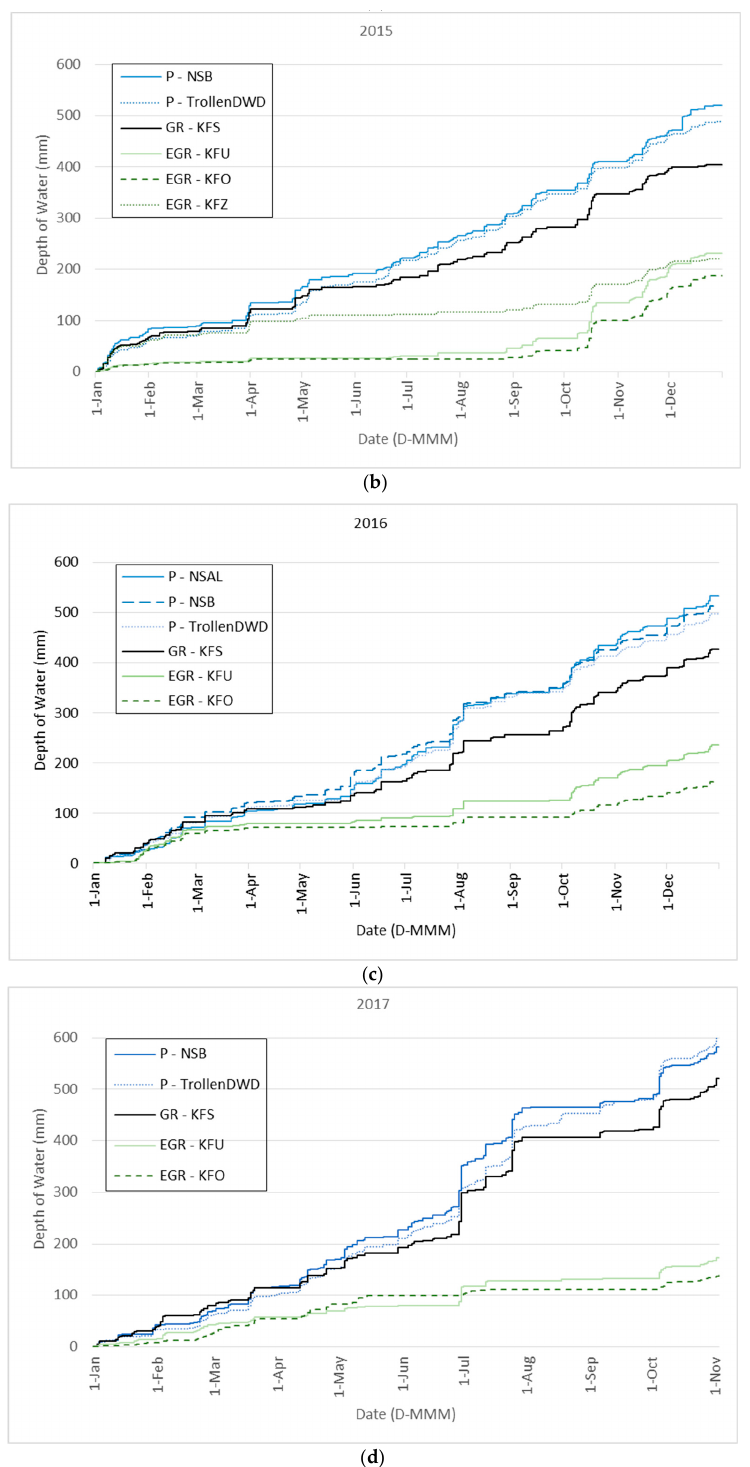
Figure 6. (a–d). Yearly precipitation (P), runoff of extensive green roofs (EGR), and a reference gravel Figure 6. ( a – d ). Yearly precipitation (P), runo ff of extensive green roofs (EGR), and a reference gravel roof (GR) over a four-year timeline (2014–2017). (P - NS, P - NSB, P - NSAL = ombrometers at the roof (GR) over a four-year timeline (2014–2017). P - NS, P - NSB, P - NSAL = ombrometers at the at the Airport Neubrandenburg-Trollenhagen (5 km, ID 5109) for reference; GR = reference gravel roof (10 cm depth); EGR - KFU / EGR - KFO = extensive green roofs on building No. 3 (10 cm depth); EGR - KFZ = extensive green roof on building No. 2 (recycling material, 10 cm depth); ( Blue = precipitation, green = extensive green roofs, black = gravel roof for